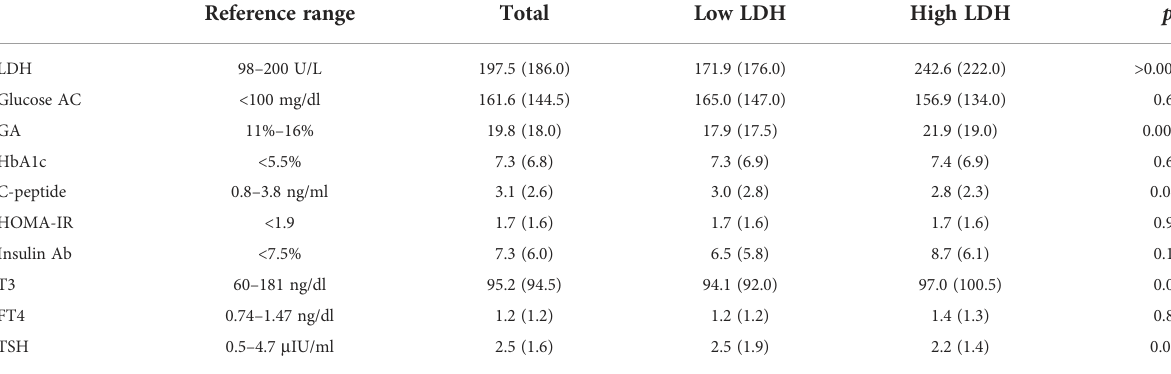
TABLE 3 The association of related markers between low (<200 U/L, n = 44) and high ( ≥ 200 U/L, n = 28) levels of serum LDH. Reference